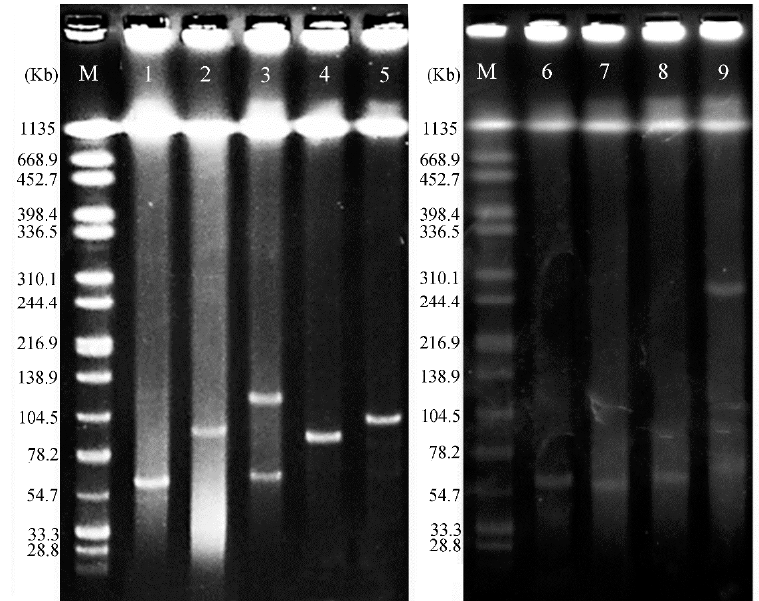
Figure 3. Identification of mcr-1 gene-carrying plasmids of transconjugants by S1-PFGE. Lanes 1-9: TA15, TA59, TA103, TA78, TA95, TA9, TA20, TA32, TA114. Lane M, Salmonella serovar Braenderup H9812.